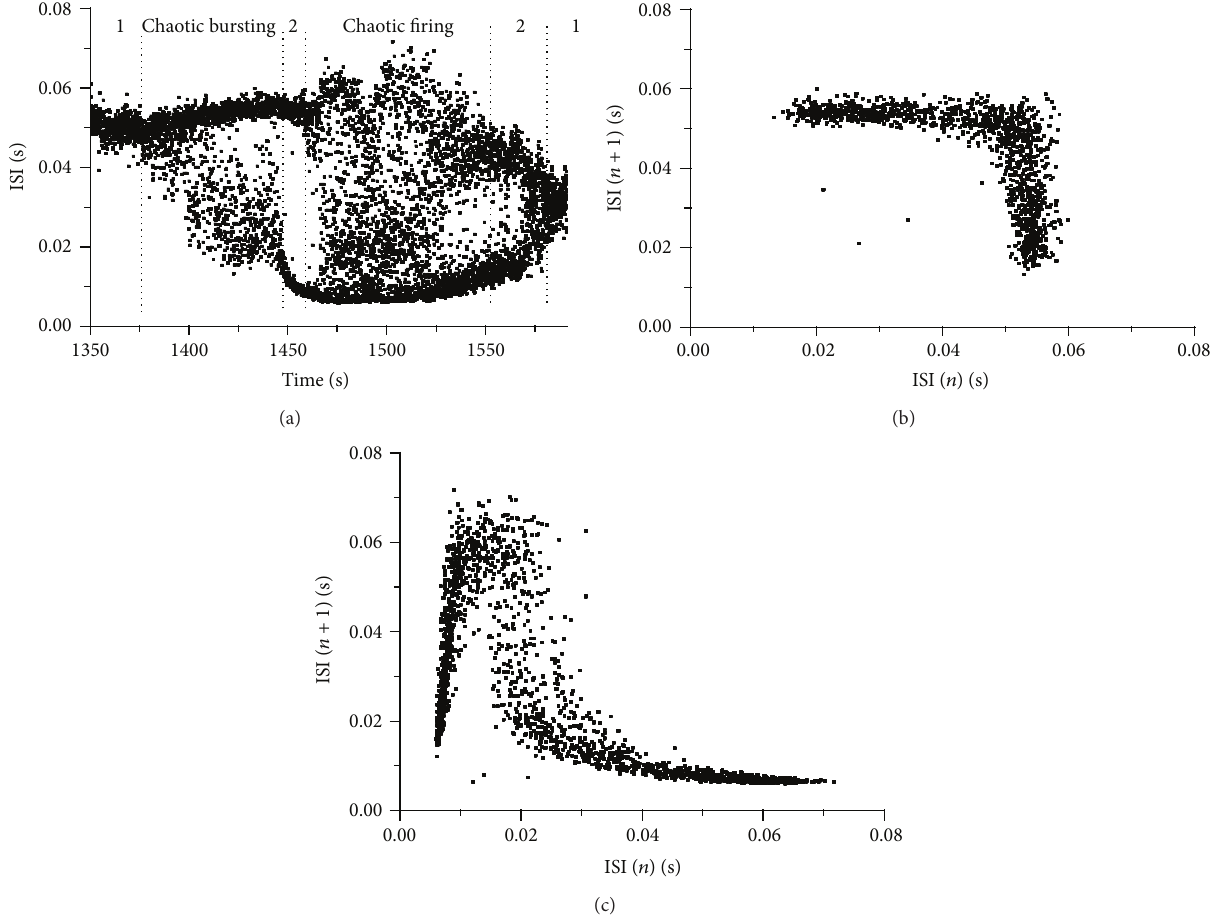
Figure 8: Example 3 of bifurcation scenario and firing patterns observed from a pacemaker with decreasing [ Ca 2+ ] from period-1 bursting to chaotic bursting to period-2 bursting to chaotic firing to period-2 spiking to period-1 spiking. (b) The first return map of ISI series of the chaotic firing between period-1 and period-2 burstings. (c) The first return map of ISI series of the chaotic